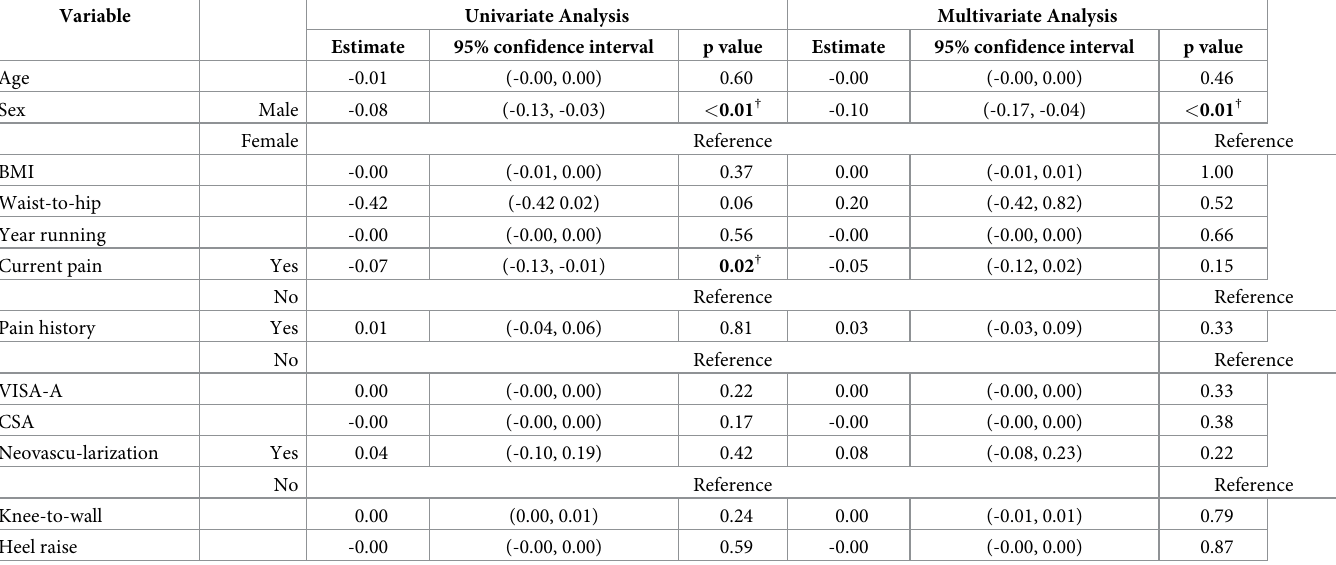
Table 3. Univariate and multivariate analyses of related predictors on peak spatial frequency